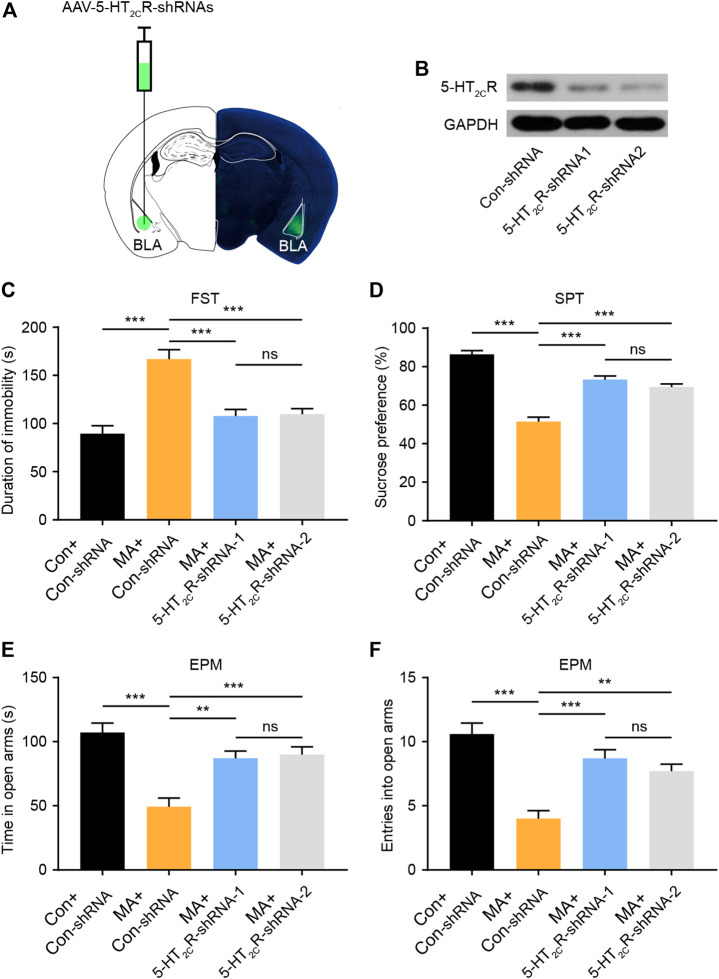
Knockdown of 5-HT2CR via AAV-shRNA injection reverses depressive-like behaviors caused by chronic MA administration. (A) Schematic of AAV vector-mediated 5-HT2CR knockdown in BLA. (B) WB results show 5-HT2CR expression after AAV-mediated knockdown. (C) Immobility time during the FST after AAV-mediated 5-HT2CR knockdown. (D) Sucrose preference in the SPT after AAV-mediated 5-HT2CR knockdown. (E) Total time exploring the open arm of elevated plus maze. (F) Total entries into open arm of elevated plus maze. Data are presented as the mean ± SEM. **p < 0.01, ***p < 0.001.